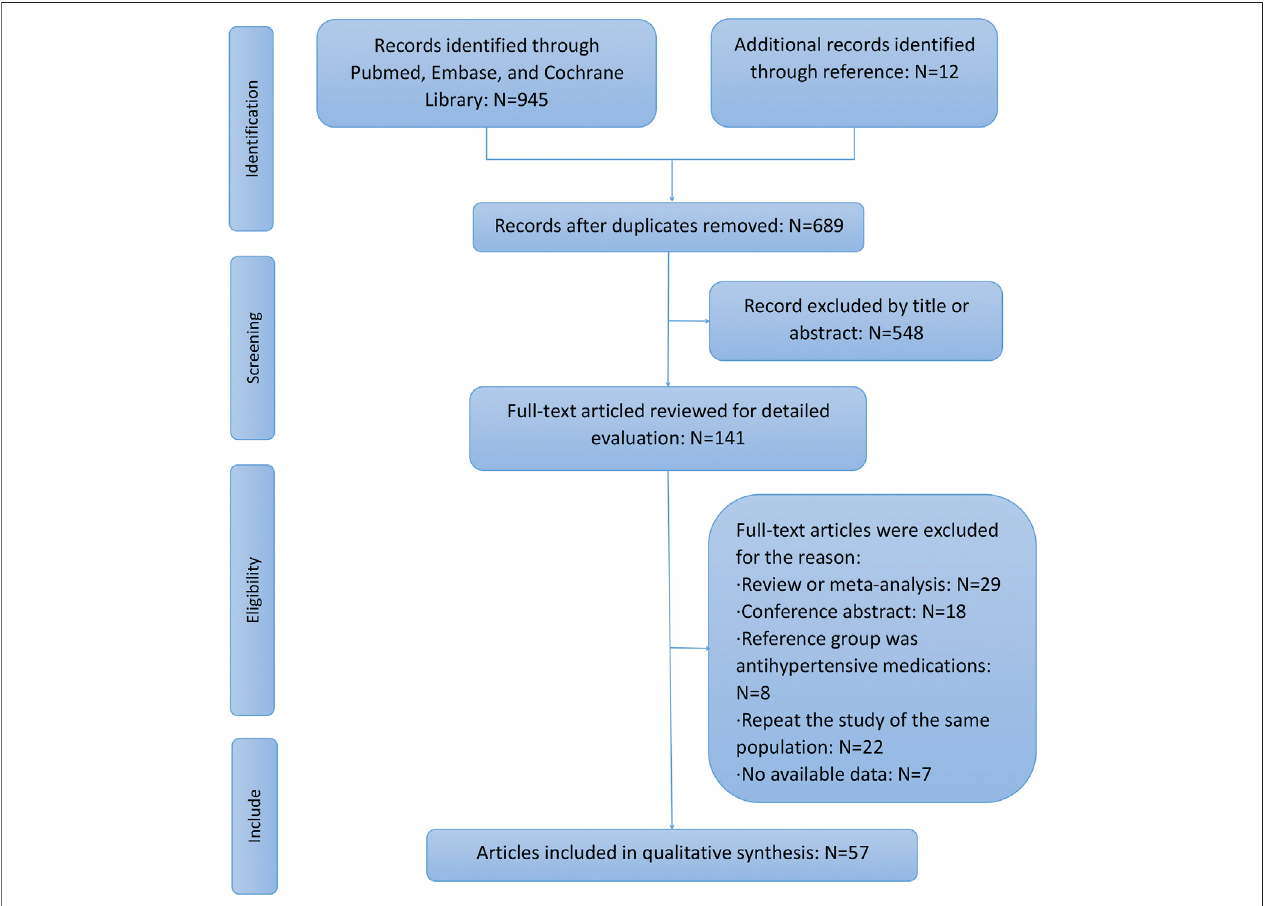
FIGURE 1 | Flow chart of the study